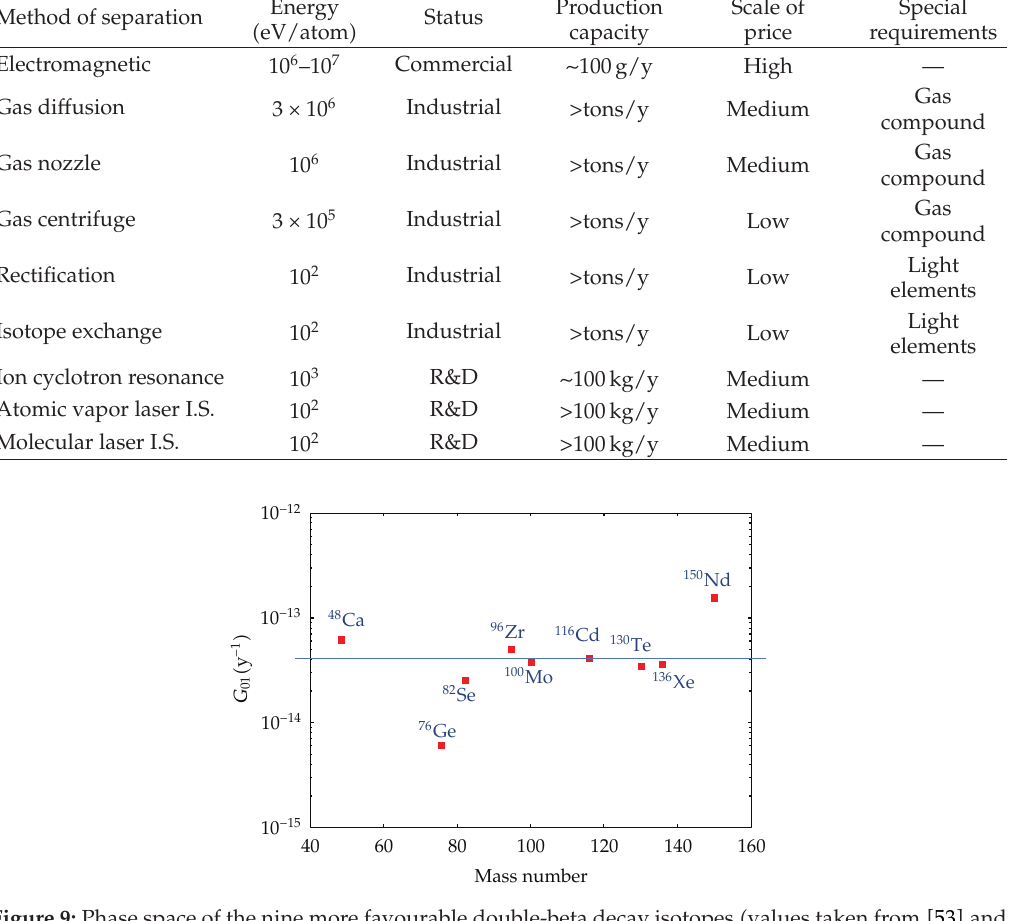
Figure 9: Phase space of the nine more favourable double-beta decay isotopes (cid:2) values taken from (cid:5) 53 (cid:6) and multiplied by g 4 with the axial coupling constant g A set at 1.25 (cid:3) . The line refers to the “average” candidate A considered in Section